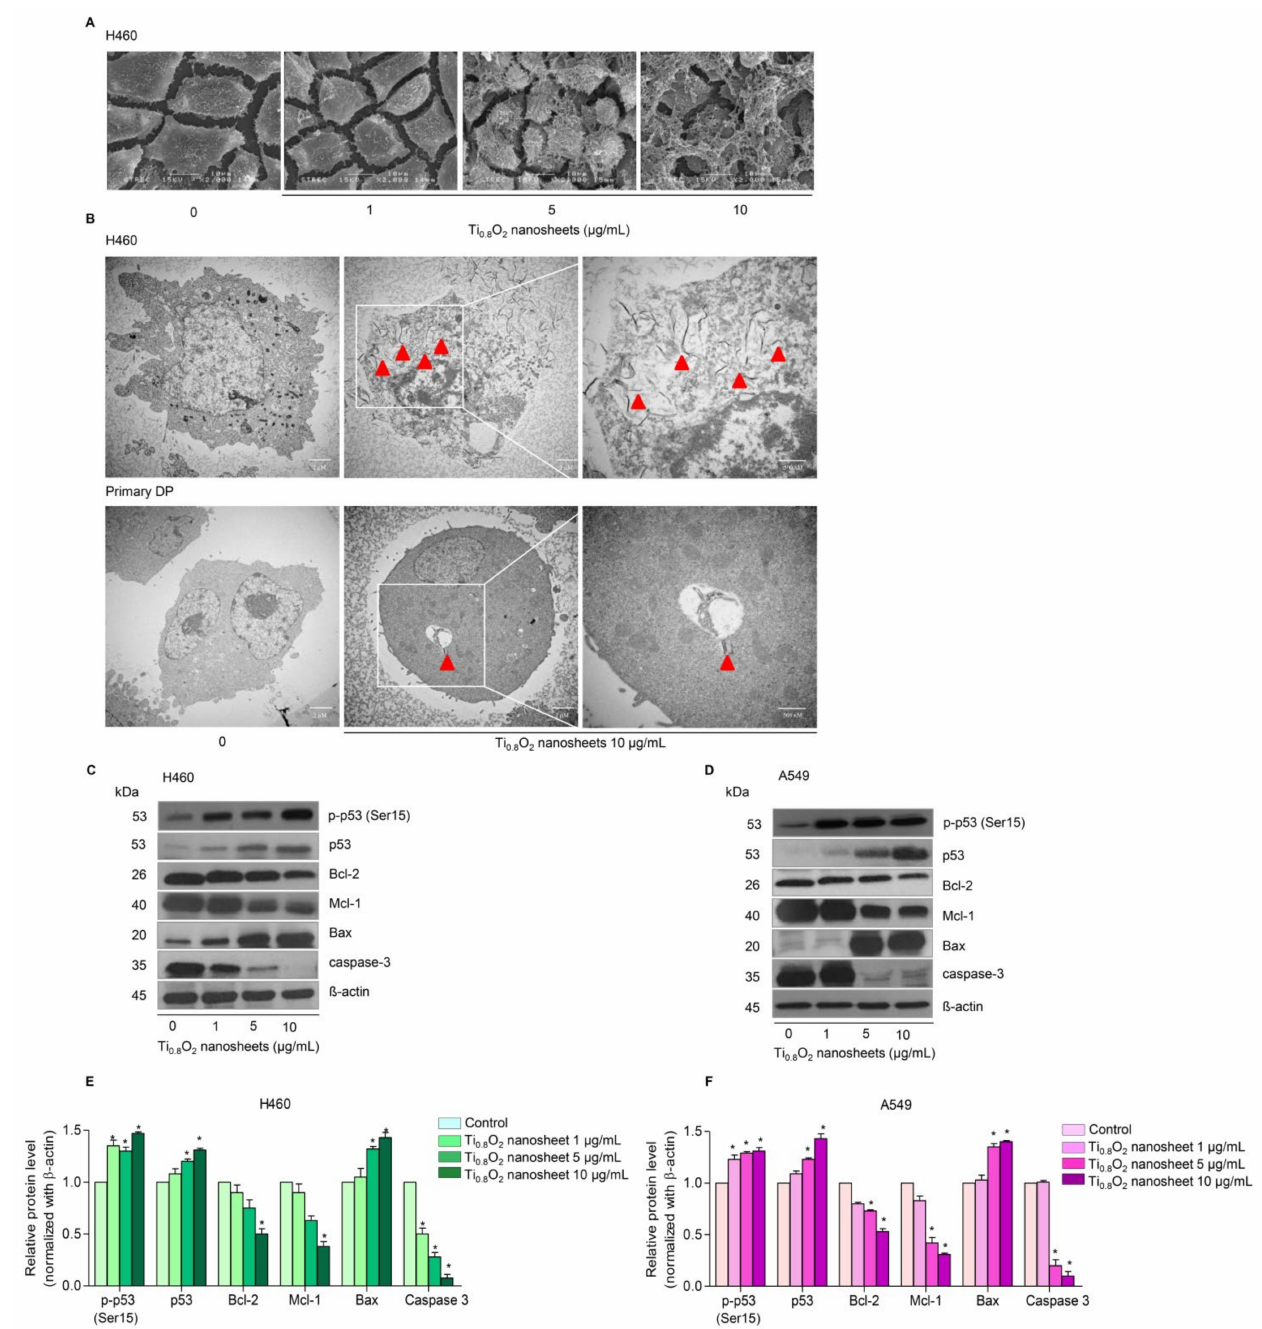
Figure 3. Morphology and characterization of cells when treated with Ti 0.8 O 2 nanosheets. ( A ) Morphology of H460 cells determined by scanning electron microscopy (SEM); ( B ) cellular uptake of Ti 0.8 O 2 nanosheets in H460 and primary DP cells at 24 h, determined by transmission electron microscopy (TEM); ( C , D ) effect of Ti 0.8 O 2 nanosheets on apoptosis-related proteins measured by Western blot analysis. Blots were reprobed with β -actin to confirm the equal loading of samples; ( E , F ) relative protein levels, calculated by densitometry. Data are shown as the mean ± SEM ( n = 3). * p < 0.05 versus non-treated